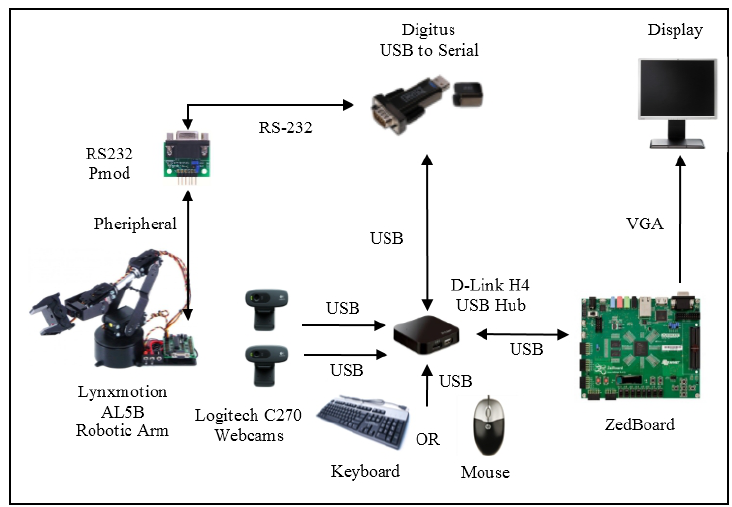
Figure 8. Block diagram of the Lynxmotion AL5B robotic arm control experiment using the ZedBoard FPGA board.